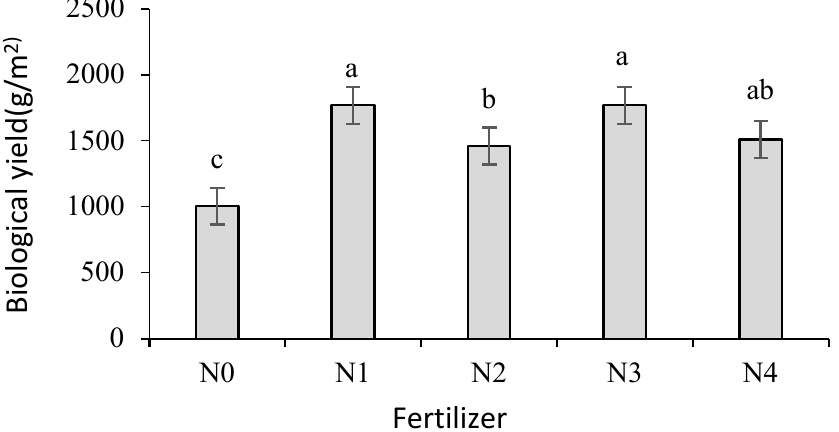
chemical fertilizer (N3) and combination of bacteria + fungi + half a chemical fertilizer (N4).